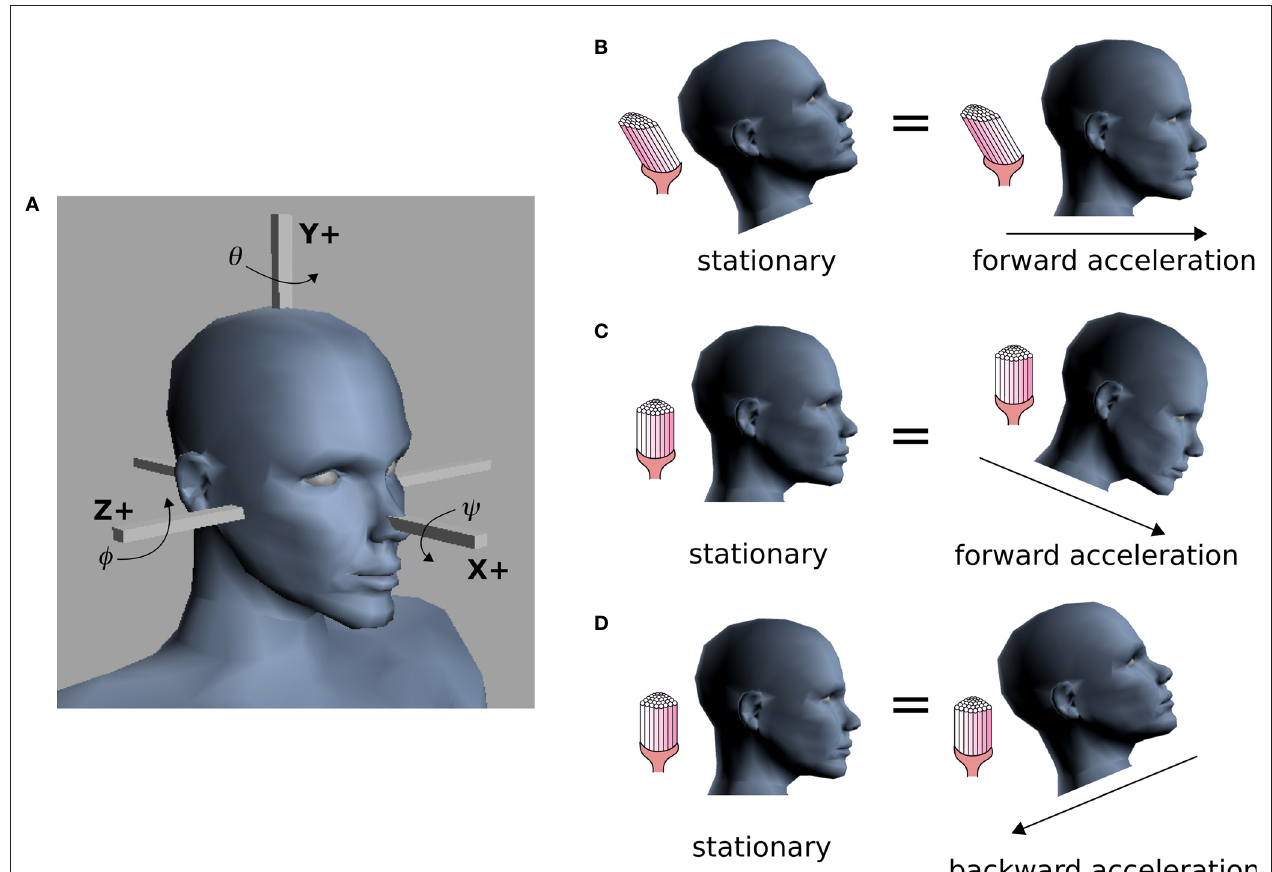
θ = 0, φ = 0 and ψ = 0. Positive pitch corresponds to an upward tilt. FIGURE 1 | Conventions and illustration of otholith ambiguities. (A) We use (B–D) Illustration of three otholith ambiguities. In a stationary backward tilt, a right-handed coordinate system with the y-axis pointing up. The yaw, pitch and ≤ ≤ (B) , the bending of the hair cells is the same as in an upright position with roll angles are denoted by −π ≤ θ ≤ π , −π π φ and − ≤ ≤π ψ π . We follow the 2 2 forward acceleration as it is the case for a stationary backward tilt and a Fick-gimbal convention, where we fi rst carry out the yaw rotation, then the pitch rotation in the rotated coordinate system, and fi nally the roll rotation in the coordinate system already rotated by yaw and pitch. The head is shown with